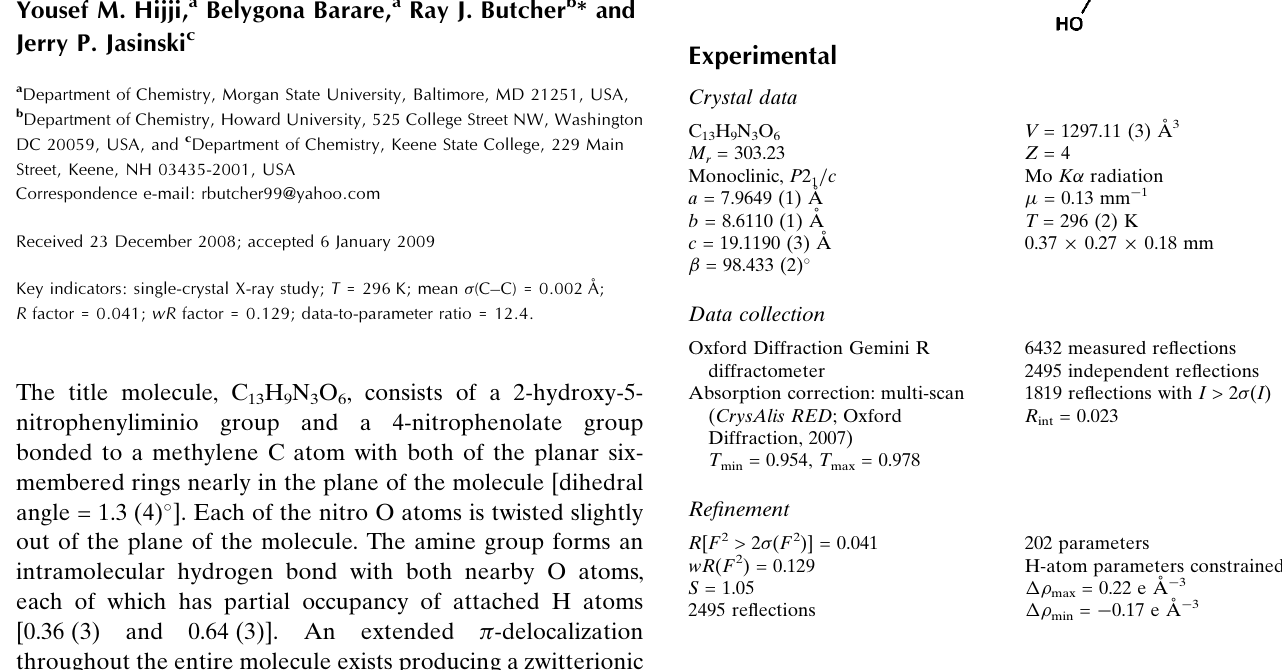
The title molecule, C